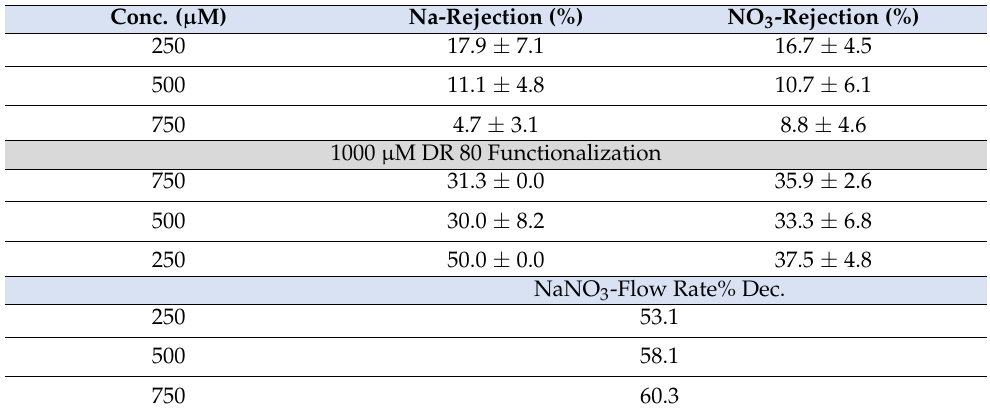
Table 4. Rejection and flow rate values for 250, 500, and 750 µ M concentrations of sodium nitrate solution pre- and post-azo-dye-functionalization, using direct red 80 at 1000 µ M for 40 min on a polycarbonate filter, already prefunctionalized with USANP